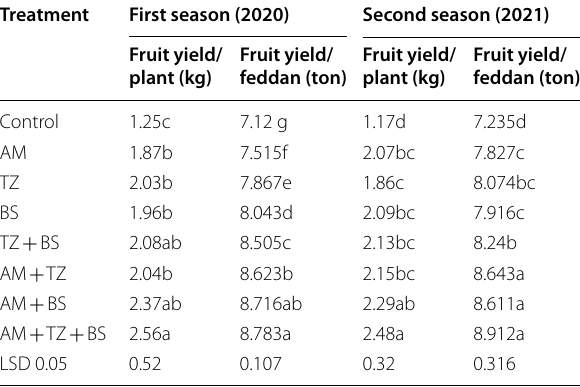
Means in a column followed by the same letters are not significantly different (LSD, P < 0.05). Arbuscular Mycorrhizal fungi (AM), Trichoderma harzianum ( TZ ) , Bacillus subtills (BS), control (without treatment)